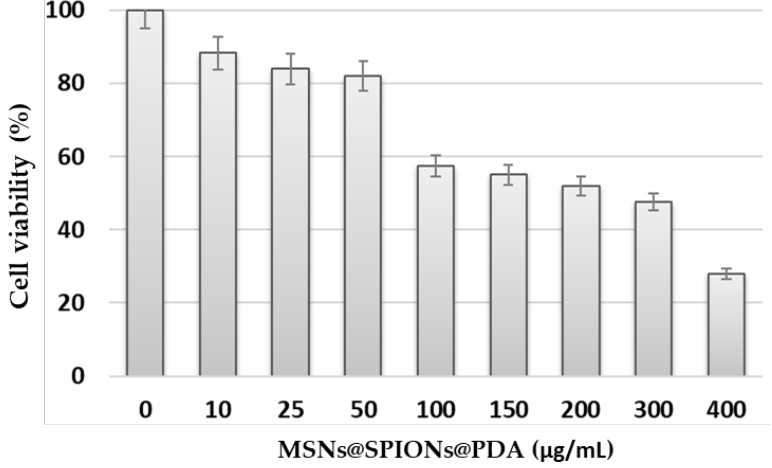
Figure 10. Cell viability of HeLa cells measured by the MTT assay (cells were incubated for 48 h with the indicated concentrations of the MSNs@SPIONs@PDA).